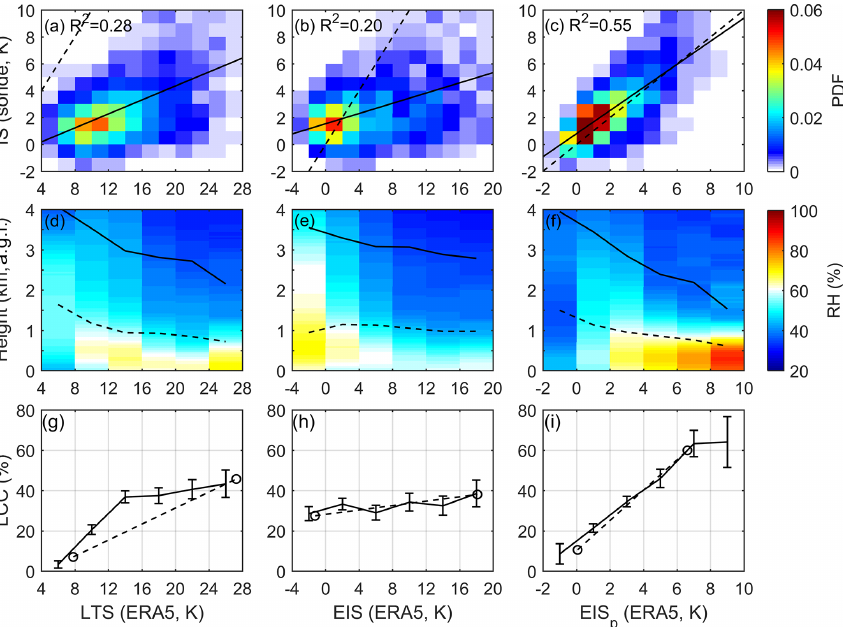
Figure 5. Joint PDFs of the SGP radiosonde-measured IS and the ERA5-derived LTS (a) , EIS (b) and EIS p (c) , respectively. In (a–c) , the solid black line is the least-squares fit, and the dashed line is the reference line of y = x . The composites of the radiosonde RH profiles based on the ERA5-derived LTS (d) , EIS (e) and EIS p (f) . The solid black and dashed lines in (d–f) are the heights of the IS and the LCL, respectively. The LCCs composited based on the LTS, EIS and EIS p are shown in (g–i) , respectively. The cycles in (g–i) correspond to the 5% and 95% quantiles of LTS, EIS and EIS p and the composited value of LCC in the bins of the smallest and largest 10% of LTS, EIS and EIS p values. Error bars in (g–i) show the 95% confidence interval of the mean based on the t test.